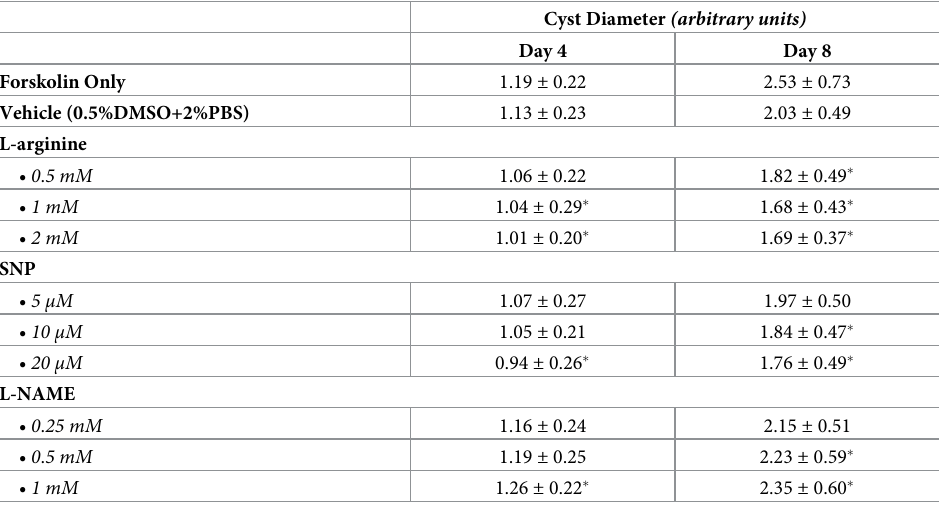
Table 1. Effect of L-arginine, SNP and L-NAME on MDCK cyst growth in vitro .